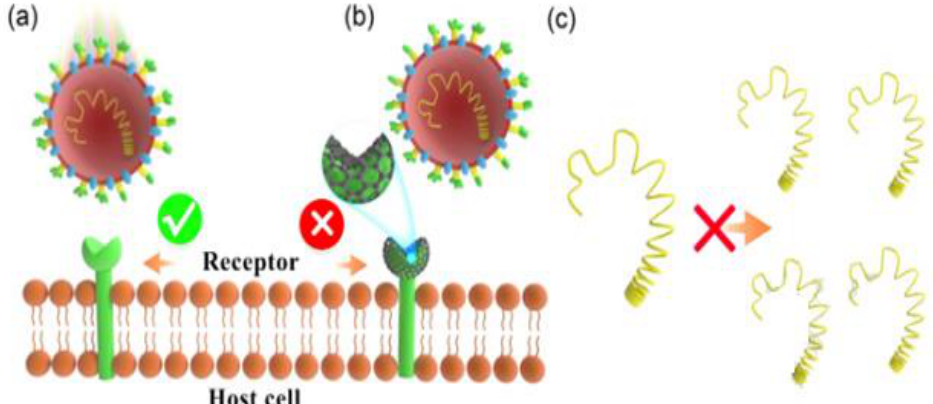
Figure 12. Scheme of the antiviral action of functionalized graphene quantum dots (GQDs). ( a ) Viral illnesses are caused by binding between the coronavirus (HCoV-229E) S-protein and the host cell receptor. ( b ) The presence of GQDs can prevent such binding. ( c ) This mechanism can inhibit the viral genome replication. Adapted from ref. [108], copyright 2021, with permission from Elsevier.